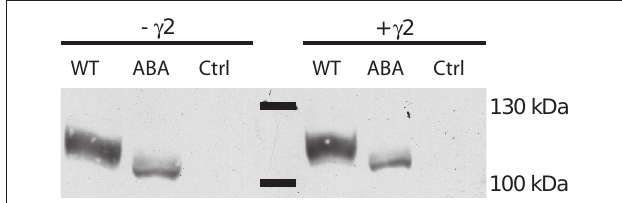
FiguRe 2 | Membrane expression analysis of gluA1 wild type (WT) and gluA1(TMD)ABA in the absence and presence of γ 2. Control lanes show preparations of oocytes injected with water or γ 2.